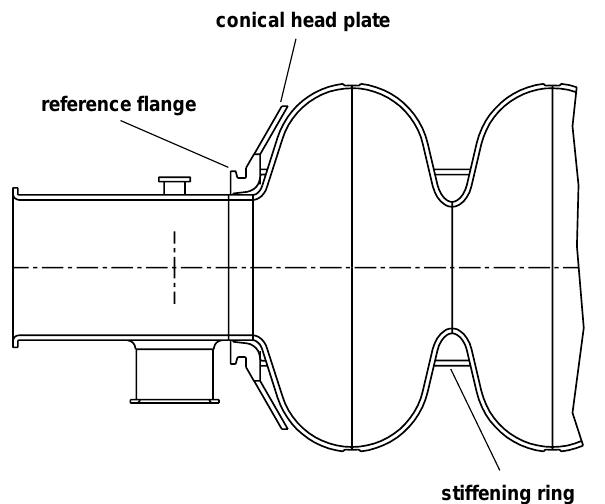
FIG. 7. The end section of a cavity with stiffening ring, conical head plate for welding into the helium tank, and reference flange for alignment.